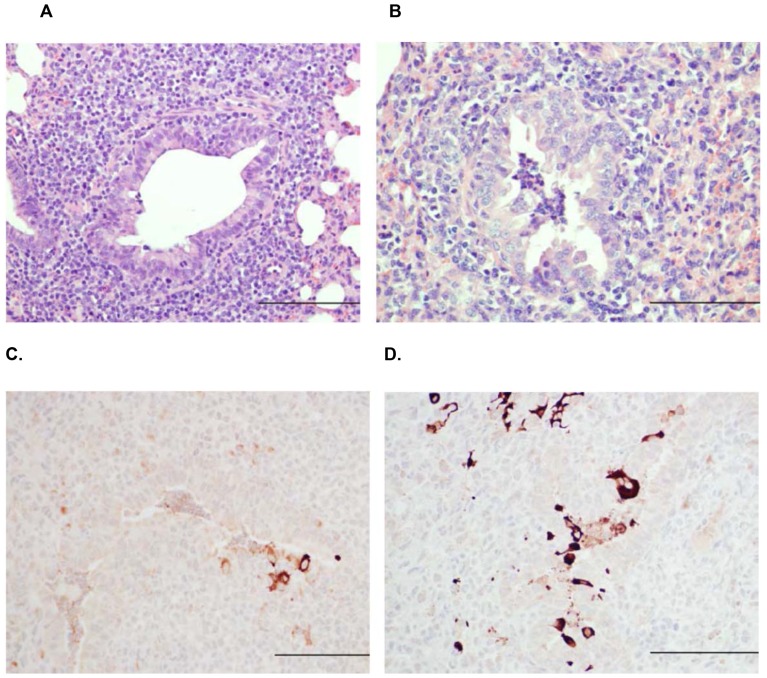
Lung of FI-RSV-vaccinated lamb with marked peribronchiolar lymphocytic infiltrates characterized by numerous, closely packed lymphocytes and plasma cells and a bronchiole that is slightly dilated but lacking intralumenal neutrophils (A) andLung of mock-vaccinated lamb with bronchiole containing neutrophils and relatively mild peribronchiolar lymphocytic infiltration characterized by a few lymphocytes and occasional plasma cells there are somewhat dispersed and not densely associated (B).Lung of FI-RSV-vaccinated lamb with marked peribronchiolar lymphocytic infiltrates and only a few cells containing RSV antigen (C). Lung of mock-vaccinated lamb with increased viral antigen distribution in multifocal cells and intensity characterized by more intense staining (D). Bar = 150 µm.